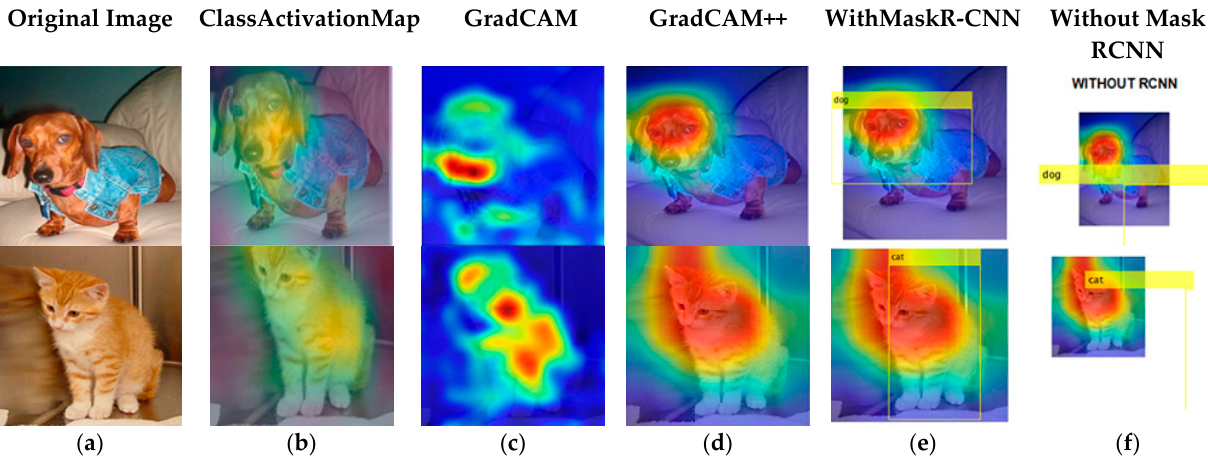
Figure 6. ( a ) Original Image; ( b ) results of Class Activation Mapping; ( c ) results of Grad-CAM; ( d ) results of Grad-CAM++; ( e ) results with Mask R-CNN; and ( f ) results without Mask R-CNN. The results of difference between with R-CNN and Without R-CNN.